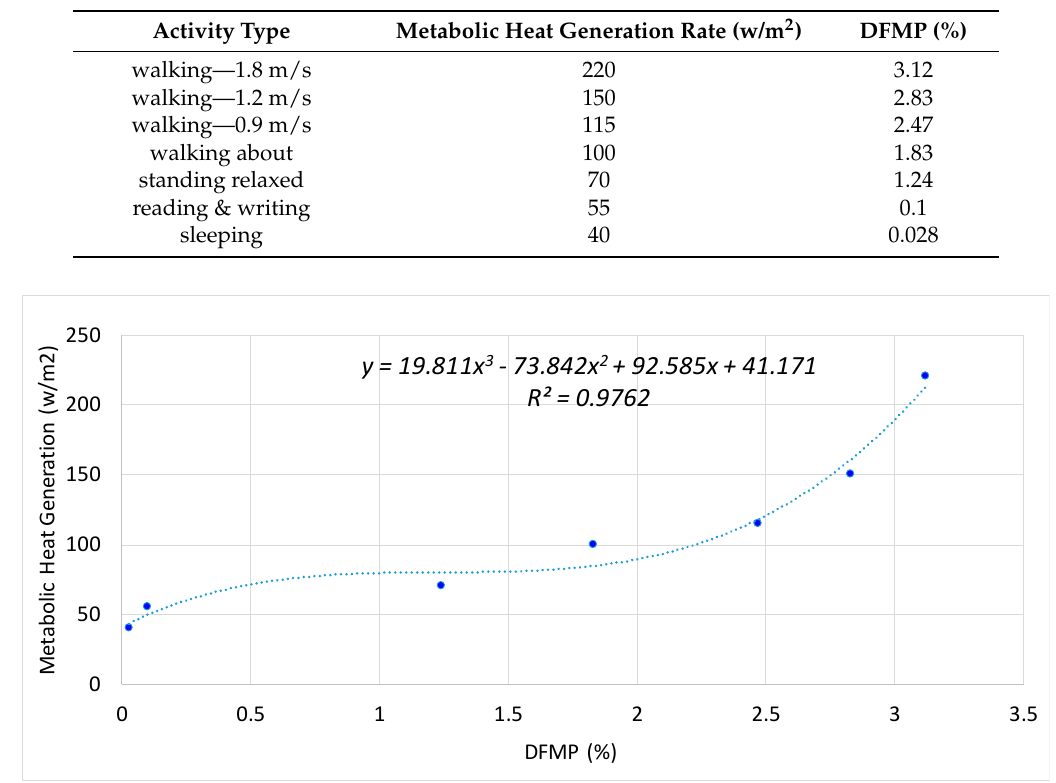
Table 6. Values of the tested DFMP with Metabolic Heat Generation Rate.